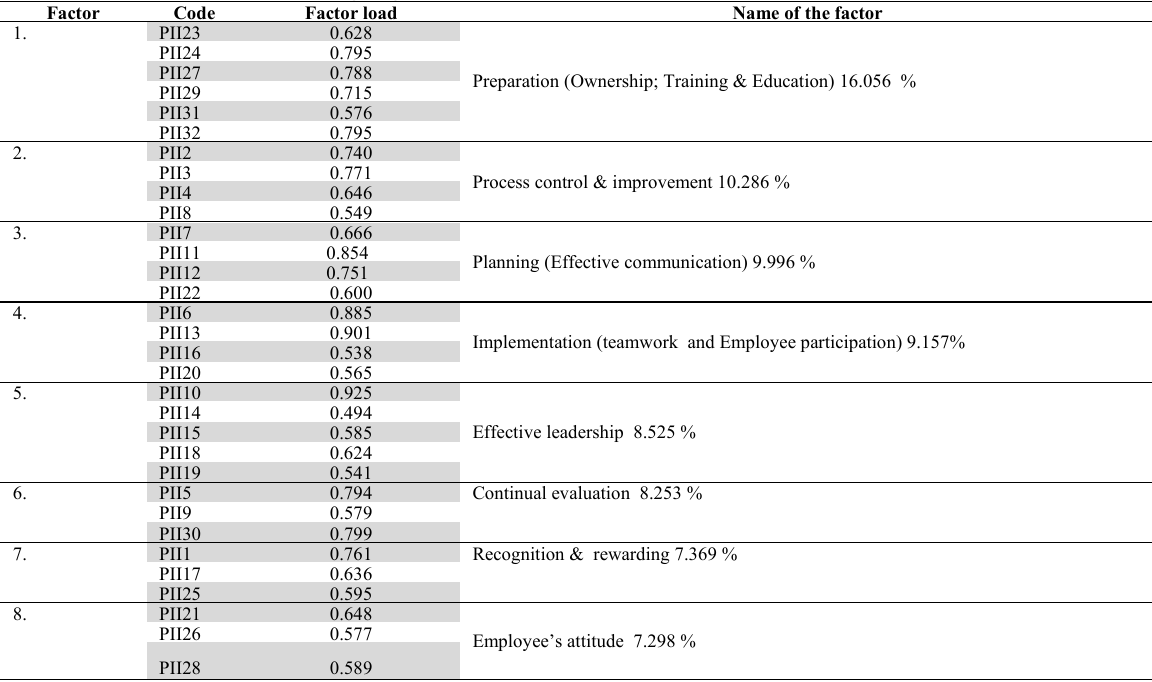
After rotated matrix mentioning eight critical success factors